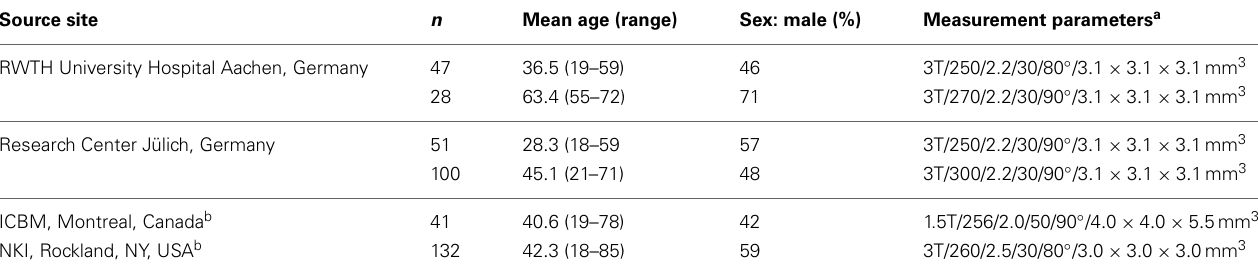
Table 2 | Characteristics of the